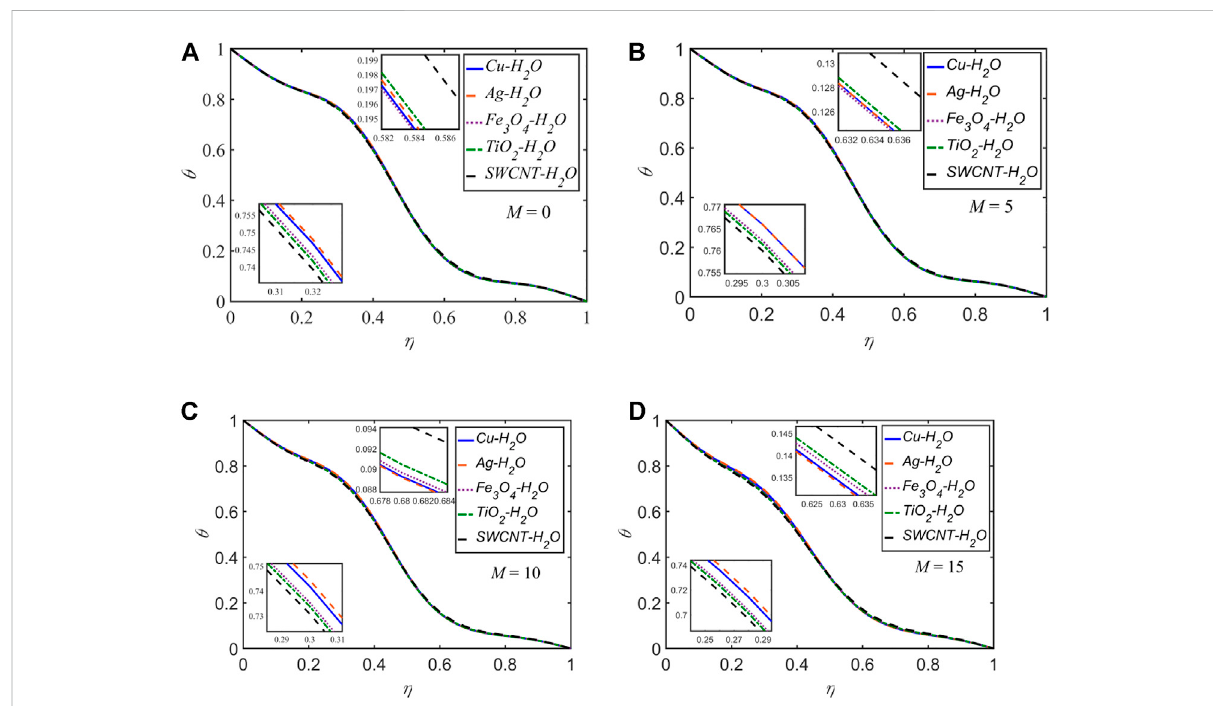
The temperature pro fi le θ versus η at x (cid:2) 2 and t (cid:2) 0 . 25 for the fi ve NFs for distinct values of M .